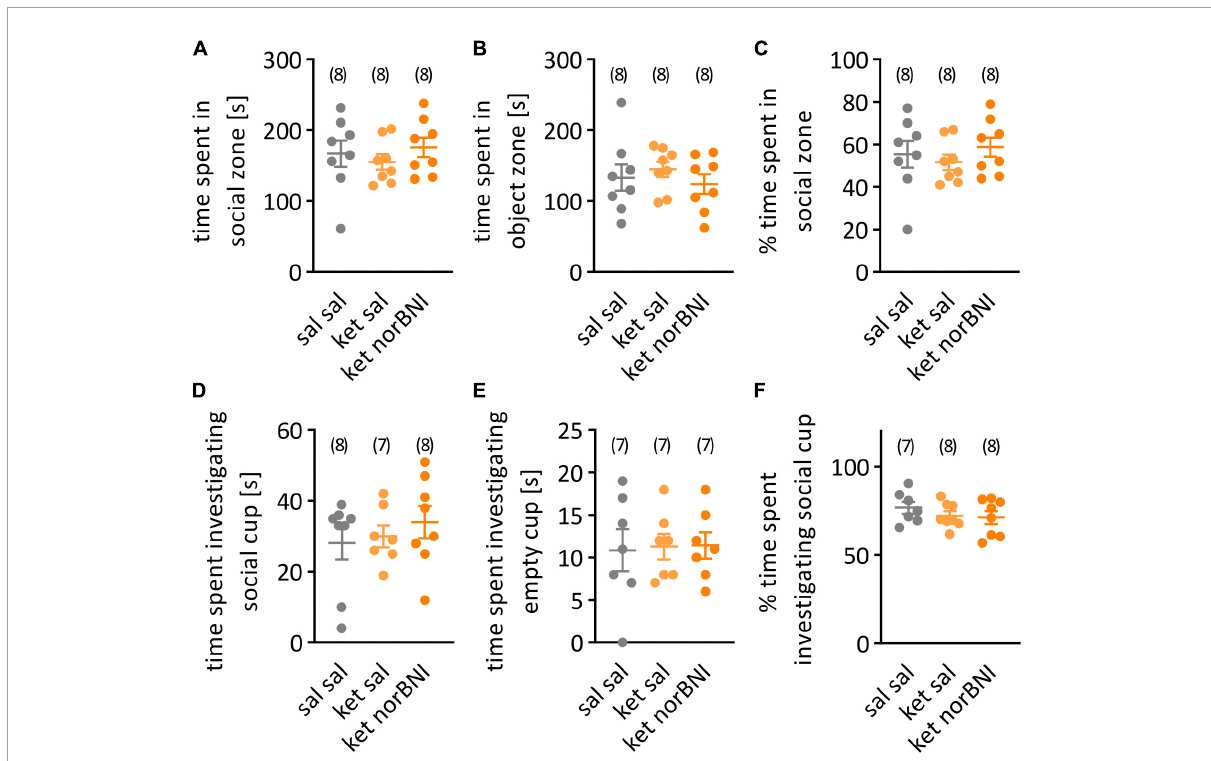
FIGURE4 Social interaction in the open field. (A) Time spent in in the half of the cage with the partner mouse under the wire cup. (B) Time spent in the empty-cup zone. (C) Percent time spent in the social zone. (D) Time spent investigating the wire cup containing a partner mouse. (E) Time spent investigating empty cup. (F) Percent time spent investigating social cup. Groups are labeled as follows: “Sal sal” is the control group with only saline injections, “ket sal” corresponds to ketamine treatment and then saline, and “ket norBNI” is ketamine followed by norbinaltorphimine. Results are shown as mean and SEM. The numbers above the graphs indicate group sizes.